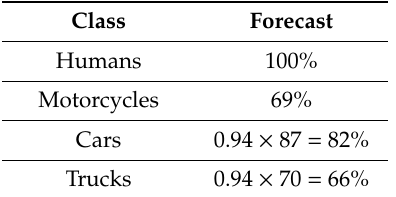
Table 11. Cases 6 and then 4 prediction accuracy.